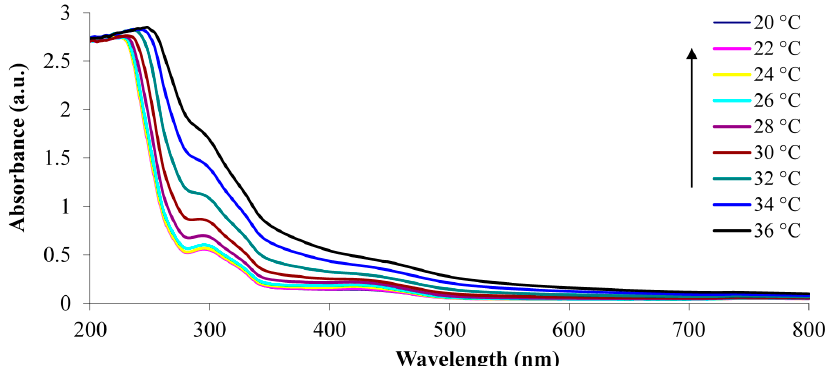
Figure 3. UV-Vis absorbance spectra of the white light irradiated 0.1% w/w p(NiPAAm-BSP-AA) linear copolymer solution in DI water.